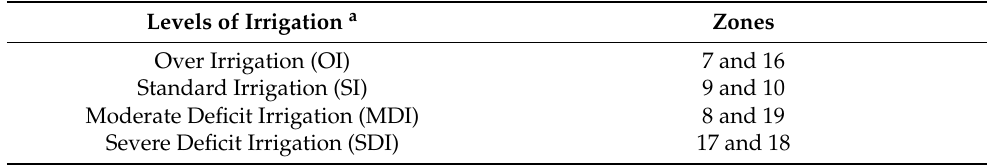
Table 3. Levels of irrigation and corresponding zones. Levels of Irrigation a Zones Over Irrigation (OI) 7 and 16 Standard Irrigation (SI) 9 and 10 Moderate Deficit Irrigation (MDI) 8 and